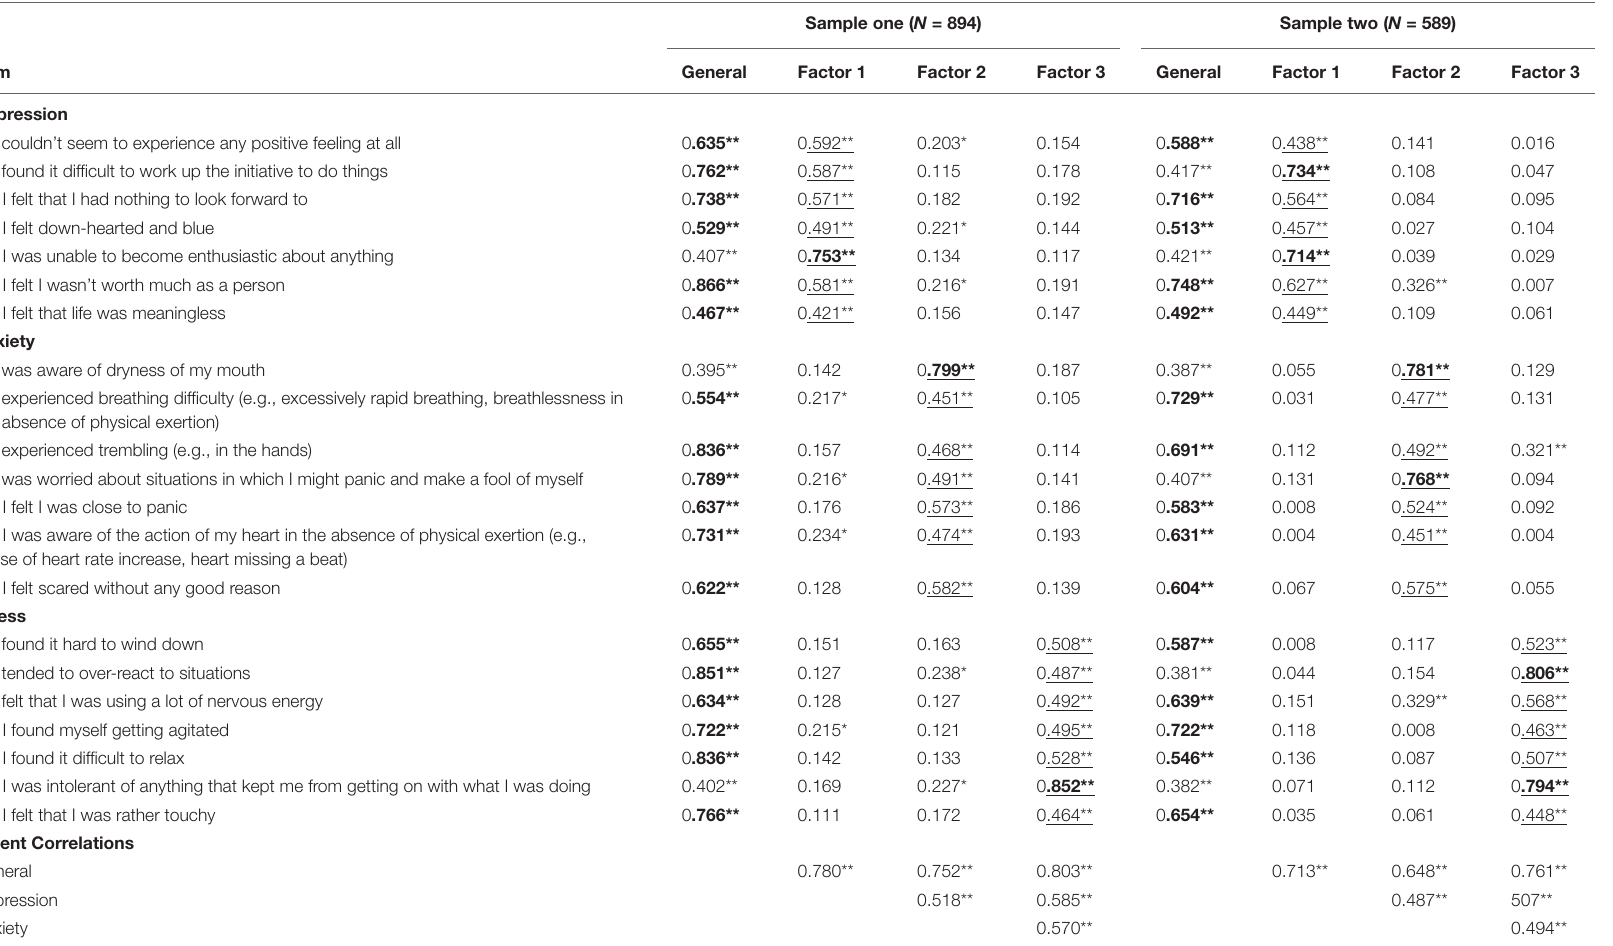
TABLE 3 | Parameter estimates and latent factor correlations for bifactor